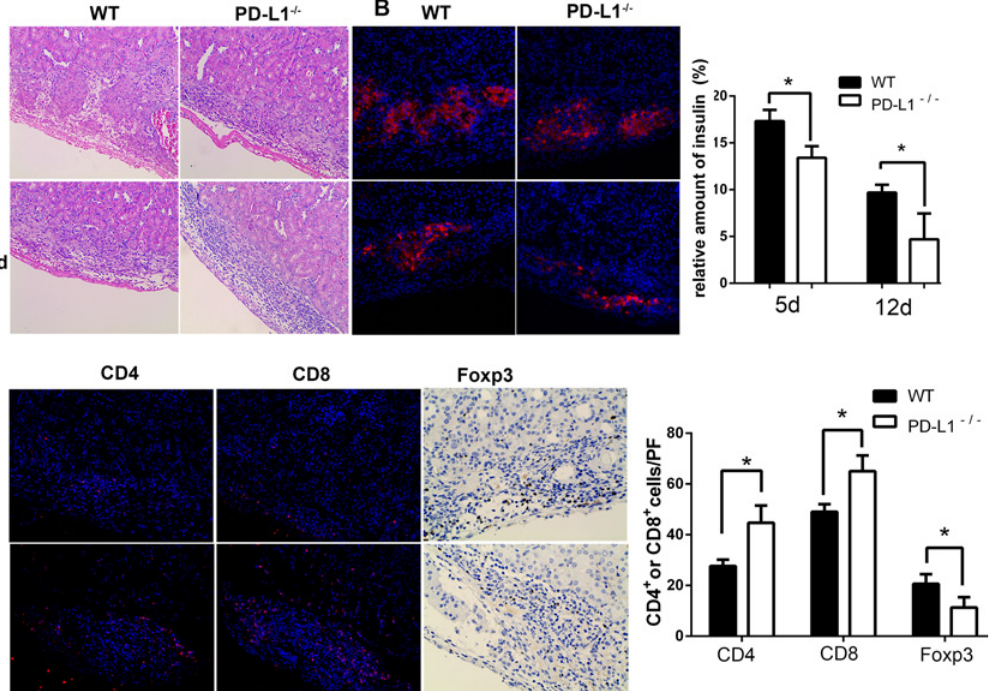
Fig 3. The residual β cells and infiltration of inflammatory cells at 5 and 12 days post-transplantation. Representative images of allografts in the renal capsules are shown (A) Grafts were harvested and stained for insulin with H&E. (B) Immunofluorescence staining for insulin (in red) in islet grafts. The right panel shows the relative quantification of the insulin signal analysed with Image-Pro Plus 6.0. Less insulin secretion was observed in the PD-L1-deficient group at both 5 and 12 days post-transplantation. (C) Immunofluorescence staining for inflammatory cells (CD4 + and CD8 + , in red; Foxp3 + , in brown) in islet grafts. Nuclei were counterstained with DAPI (in blue). Magnification is 200× ( * P < 0.05).